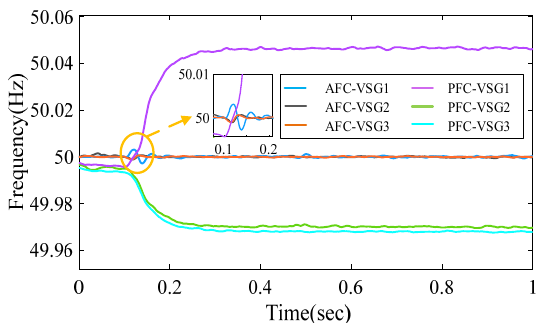
Figure 12. Frequency regulation ability between the PFC-VSG and the AFC-VSG.